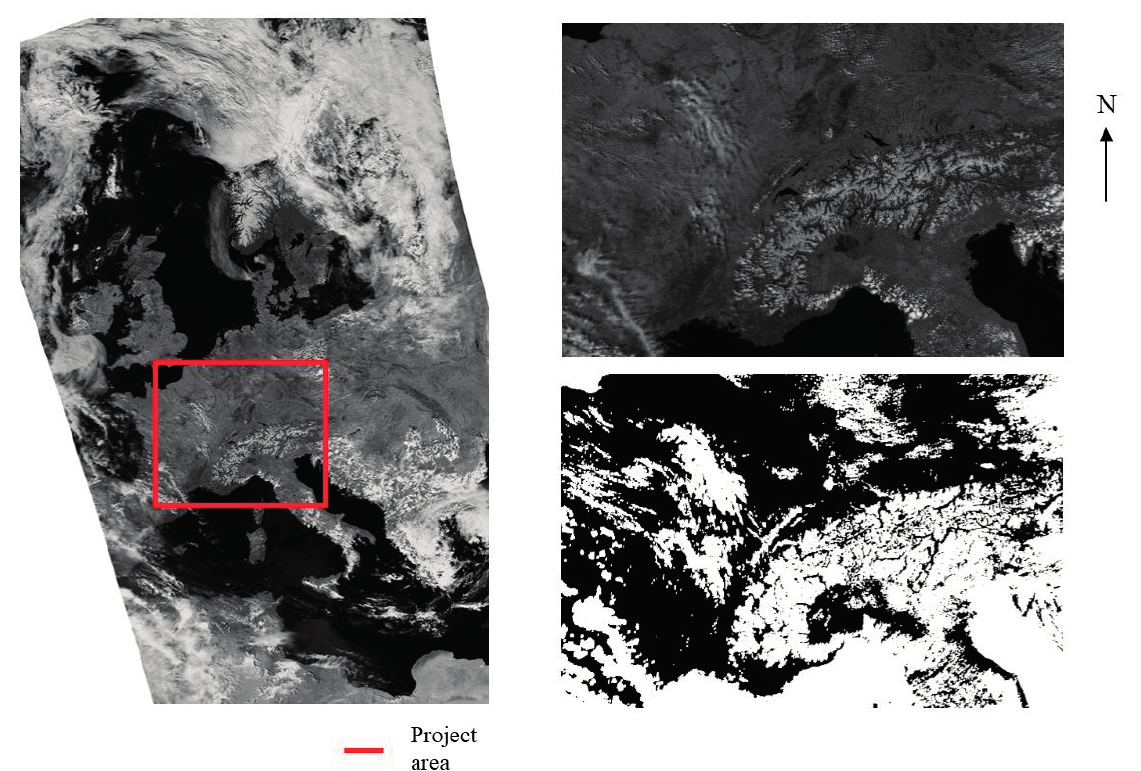
Figure 1. AVHRR Band-2 orthoimage acquired from NOAA-18 on 7 May 2008 at 12:08 ( left ). The subarea used for relative accuracy tests is marked with red rectangle on the full image and shown in upper right image. The cloud mask used for relative accuracy tests is given in the lower right .